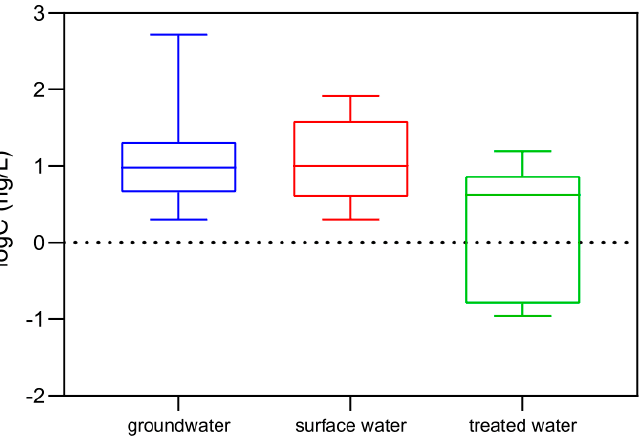
Figure 3. Boxplots showing differences among the sums of detected concentrations in different water type samples, including groundwater ( n = 287), surface ( n = 24) and treated water ( n = 14).